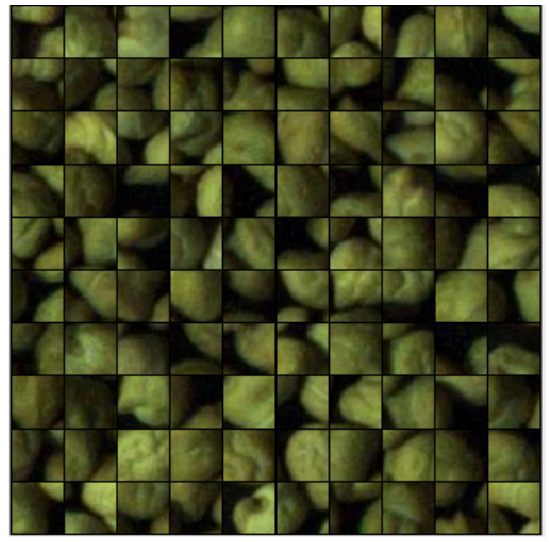
Figure 3. A random selection of 100 image patches with a division factor of 10. The size of each patch is 30 × 30